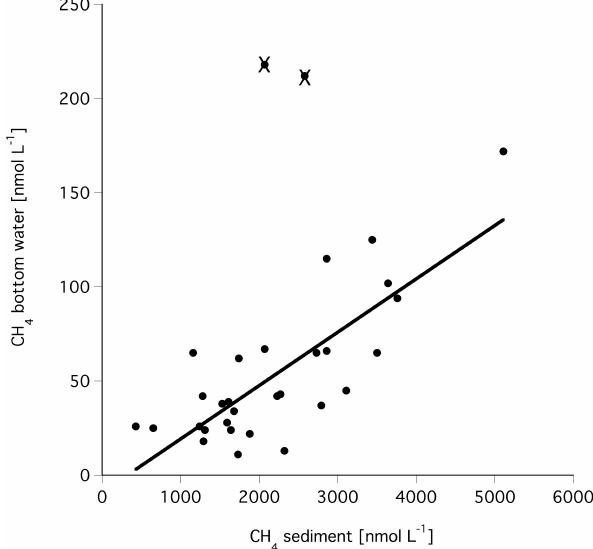
Figure 4. Correlation between the methane concentration in bottom water and the concentration in the underlying sediment for all sta- tions ( r 2 = 0 . 62, p < 0 . 001, n = 33). Two very high values from station TIII-1304 were excluded from the